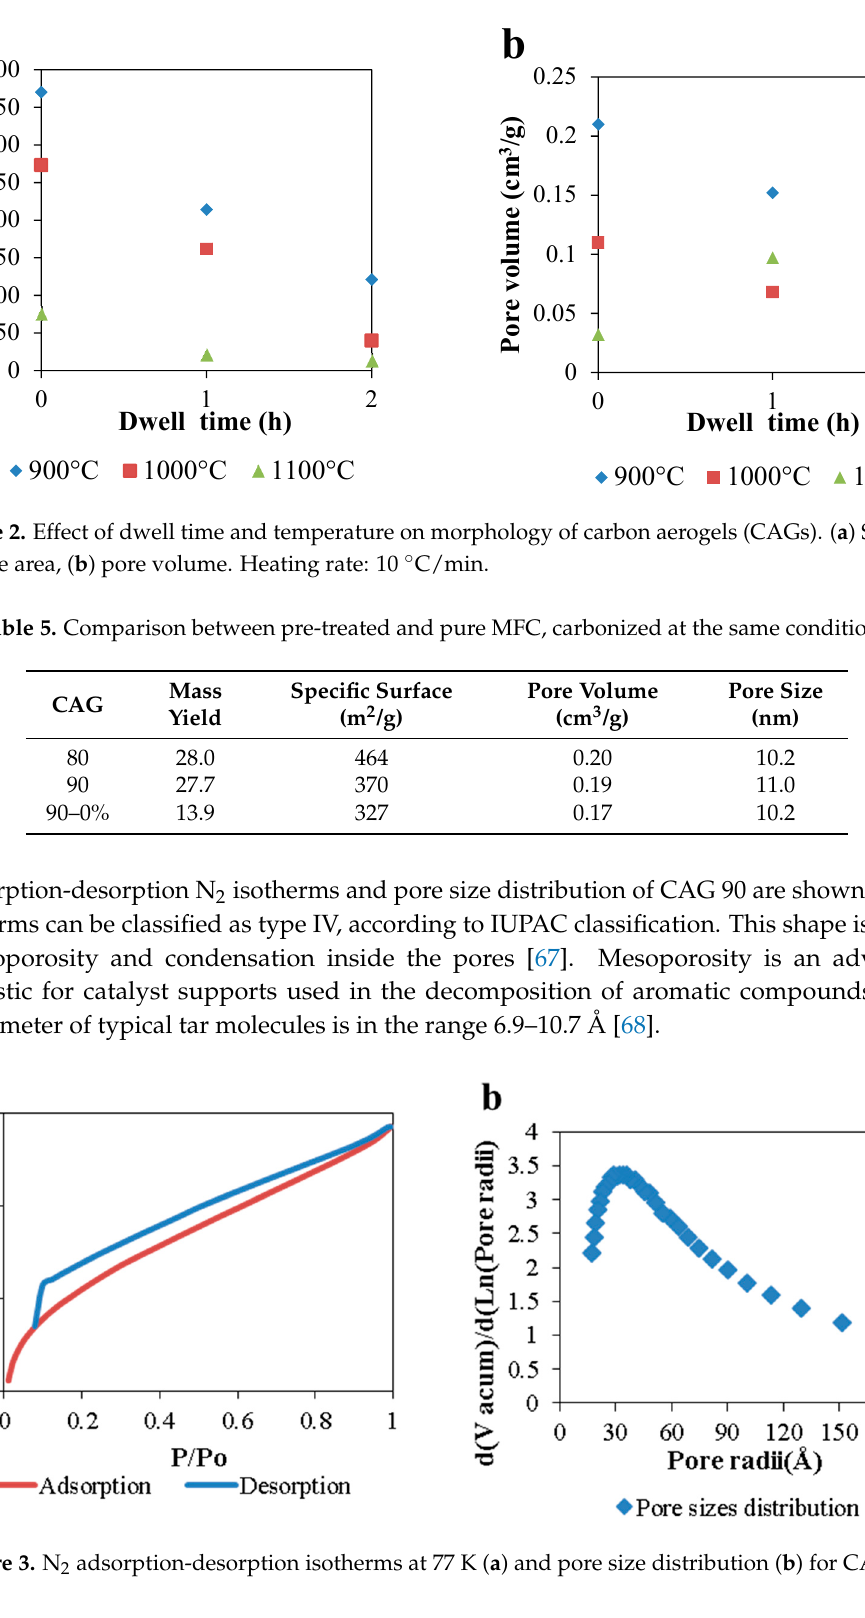
Figure 3. N 2 adsorption ‐ desorption isotherms at 77 K ( a ) and pore size distribution ( b ) for CAG 90.